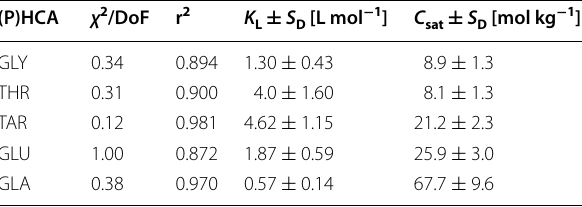
Reduced data set ( C eq